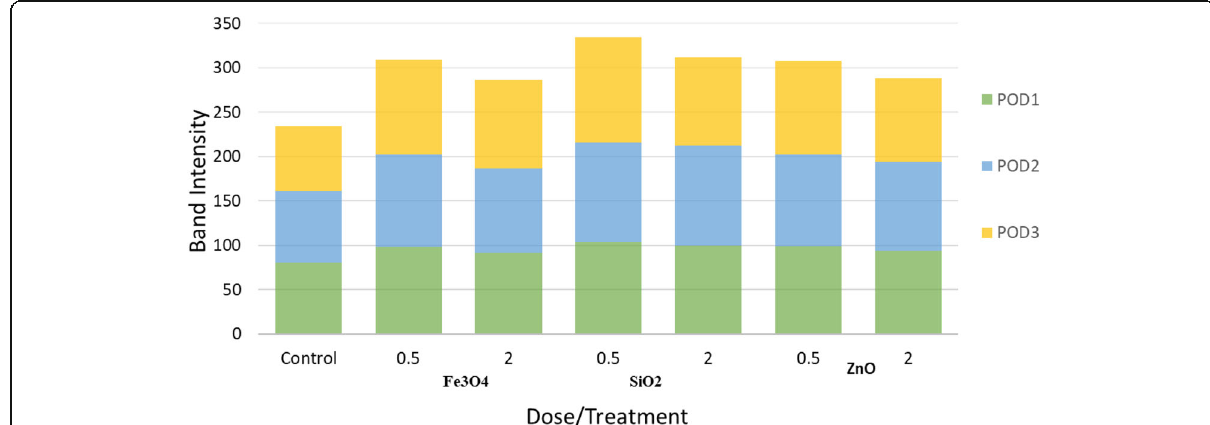
Fig. 2 Activity of POD isoforms in 45 days old Salvadora persica callus treated with Fe 3 O 4 , SiO 2 , or ZnO nanoparticles and the control. The POD activity was represented as relative band intensities of PODI, PODII, and PODIII